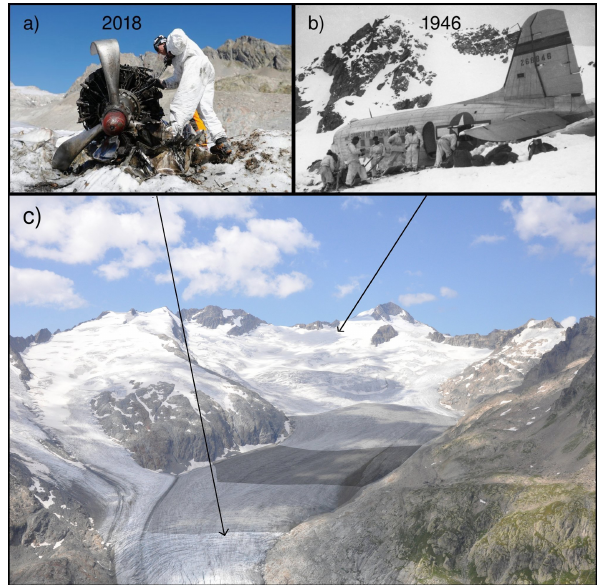
Figure 2. (a) The engine released at the surface of the glacier and found in 2018 (Foto VBS, source: https://www.vtg.admin.ch, last access: 13 November 2020), (b) the Dakota aircraft during the rescue operation in 1946 (Foto MHMLW, source: https://www. vtg.admin.ch, last access: 13 November 2020), (c) aerial view of Gauligletscher taken in summer 2019 (photo: Lars Gnägi). The light and dark shaded areas indicate the low- and high-resolution sampled zones,